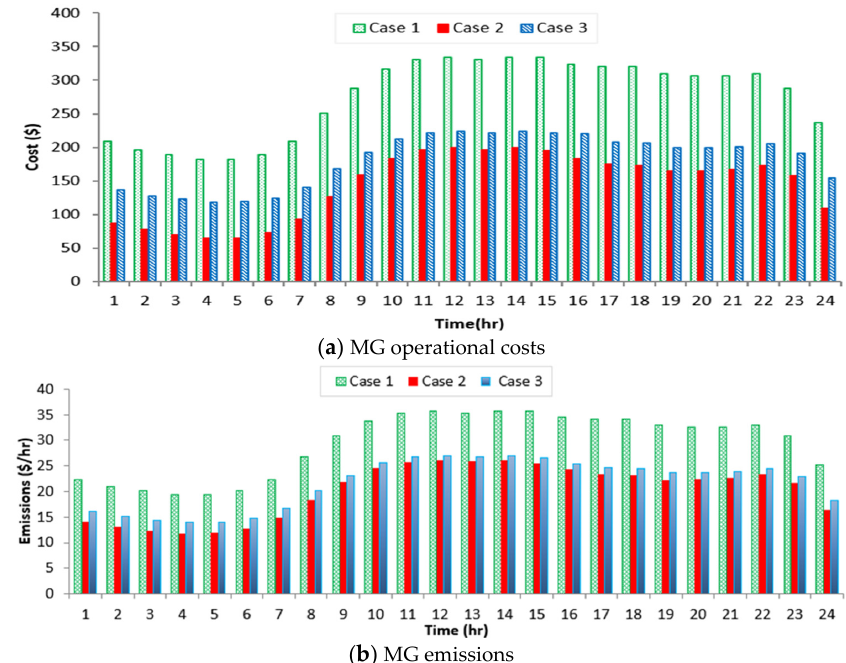
Figure 16. Hourly optimal operational costs and the associated emissions in the MG for the first MG.